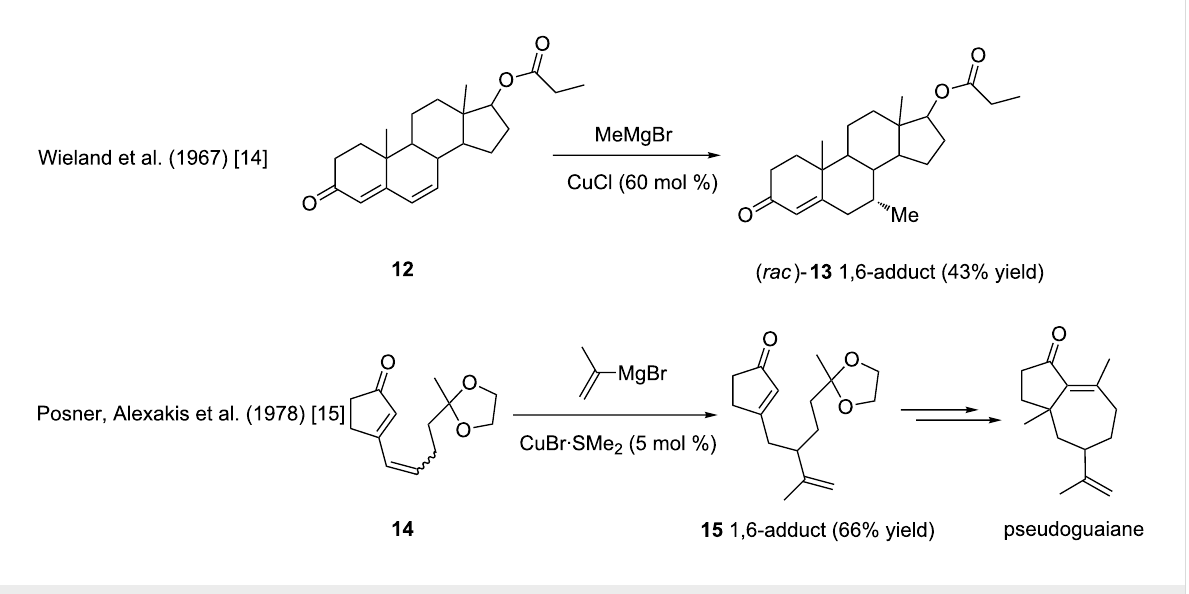
Figure 3: First applications of copper catalyzed 1,6-ACA in total synthesis.